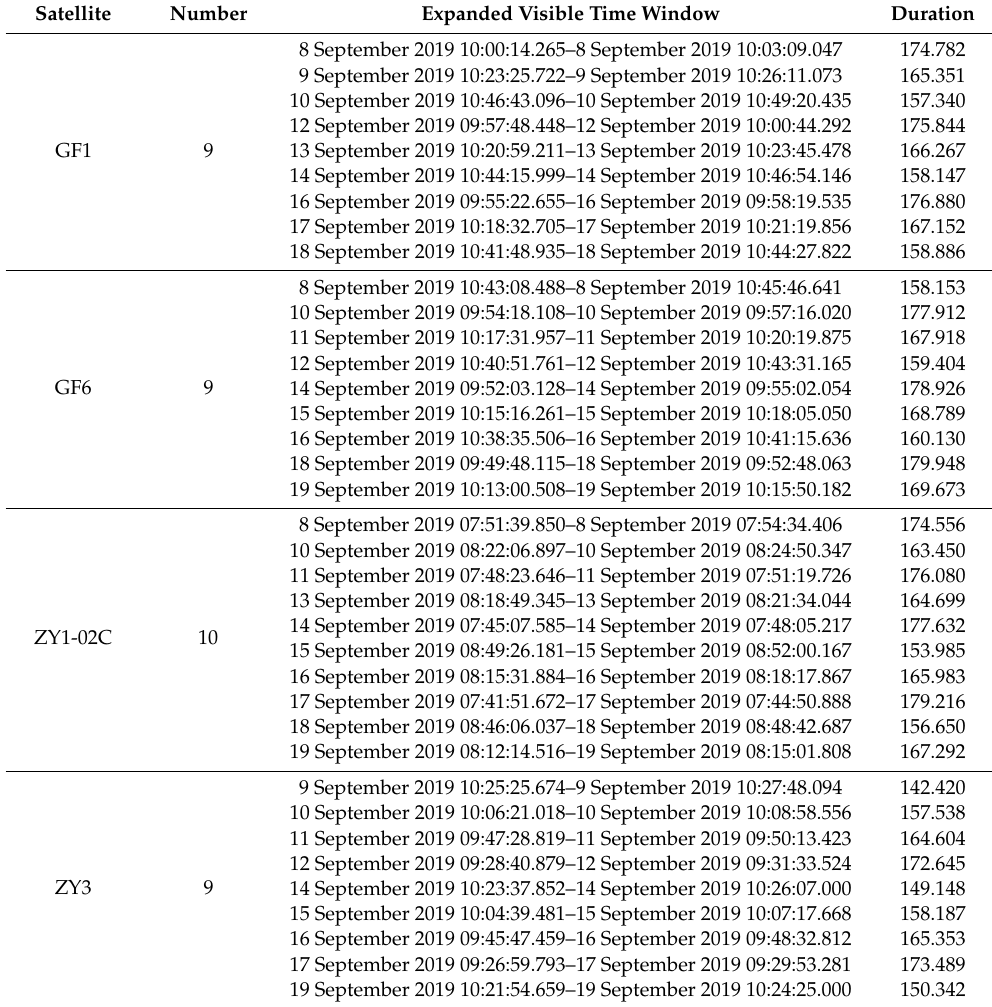
Table A2. Expanded visible time window of